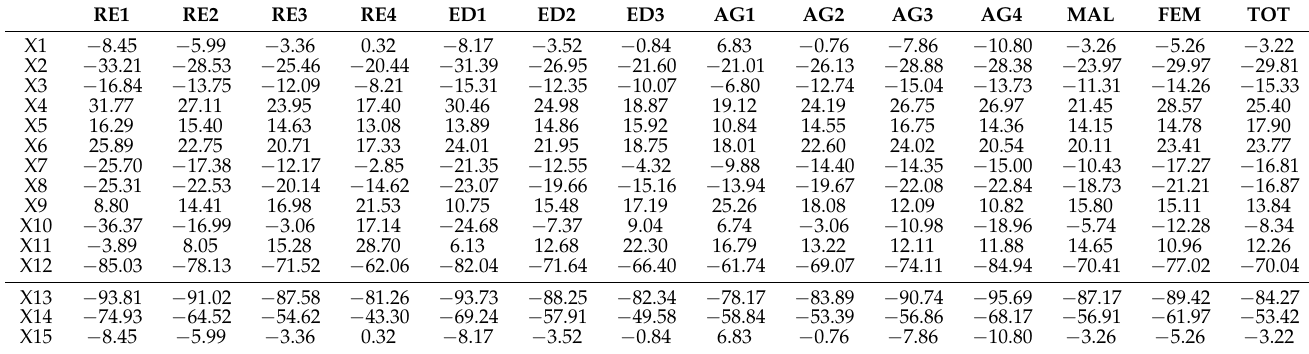
Table 4. Summary statistics—mean survey results for subcategories of consumers